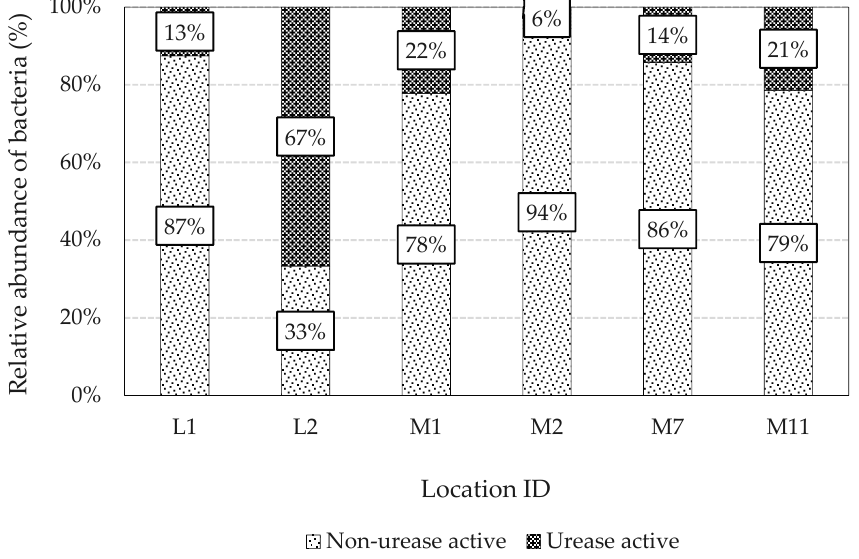
Figure 2. Relative abundance of ureolytic bacteria in different sampling locations.